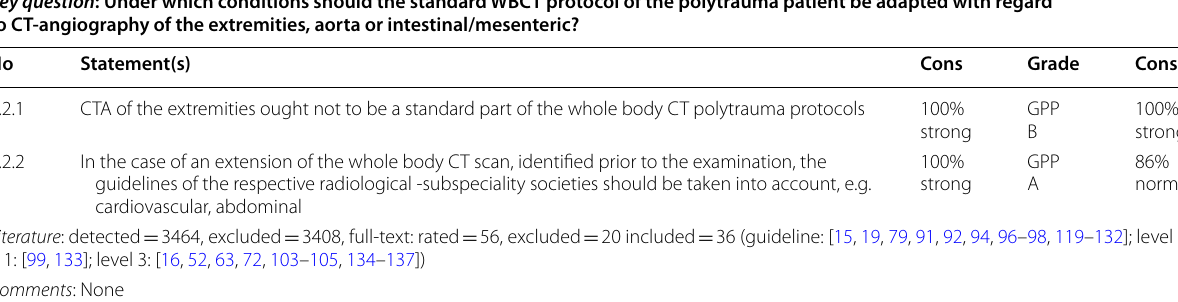
Table 16 Section 7: Whole Body CT – Special protocols, key issue 2: CT—angiography Key question : Under which conditions should the standard WBCT protocol of the polytrauma patient be adapted with regard to CT-angiography of the extremities, aorta or